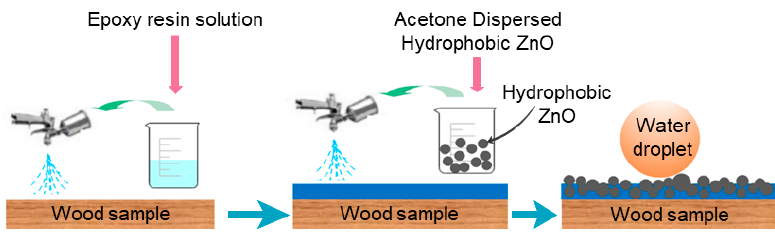
Figure 2. A schematic illustration of the superhydrophobic coating preparation on wood surfaces.